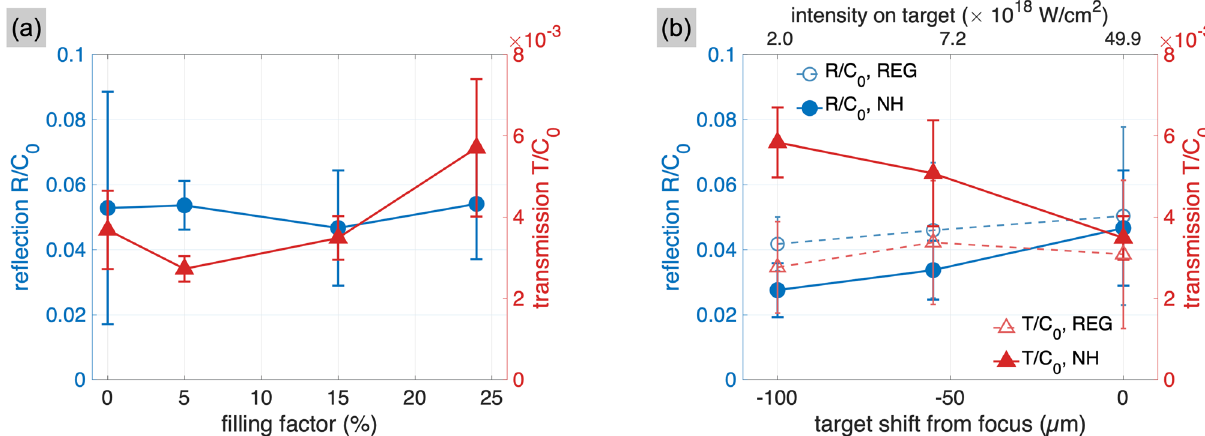
Figure 4. Reflection (dots) and transmission (triangles) signals, normalised to the signal C 0 measured in transmission without any target (blank shot), as a function of the filling factor ( a ) and of the shift of the target from the focal position ( b ). The focus scan is limited to the points where a sufficient signal to noise ratio could be detected on the reflectance screens. For all the measurements in this figure, the NH diameter was 510 nm and the foil thickness 250 nm. For the NH targets in ( b ), the filling factor was 15%